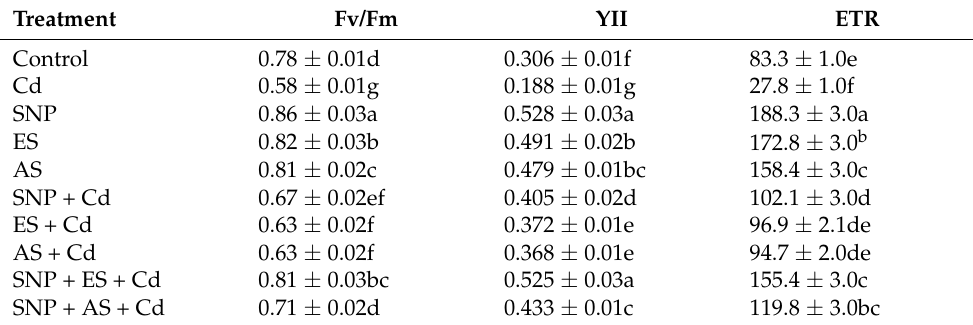
Table 3. Effect of 100 µ M SNP (NO donor) and 200 mg S kg − 1 soil of elemental sulfur (ES) or ammonium sulfate (AS) in the presence or absence of 200 mg Cd kg − 1 soil on maximal PSII efficiency (F v /F m ), photochemical quantum yield of photosystem II [Y(II)], and electron transfer rate (ETR) of mustard ( Brassica juncea cv. Giriraj). Data are presented as treatment mean ± SE ( n = 4). Data followed by same letter are not significantly different as determined by LSD test at p < 0.05.